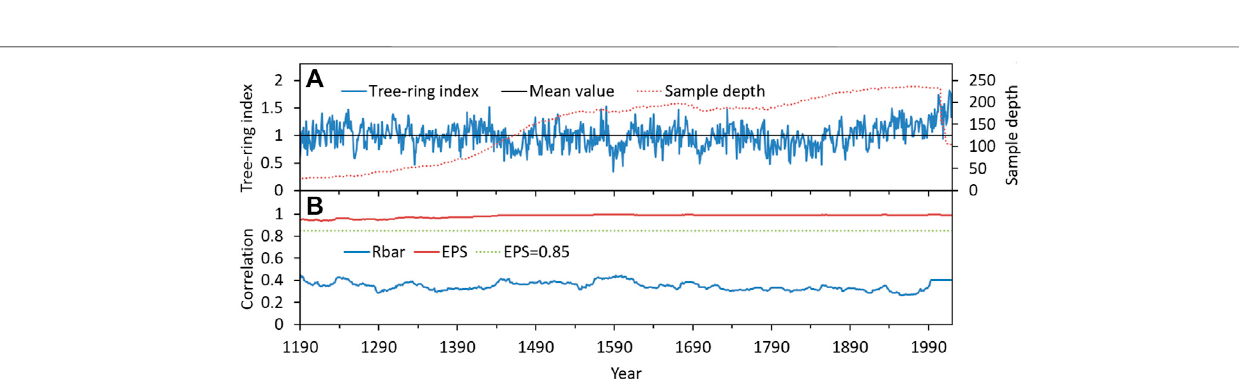
FIGURE 2 | Plots of (A) the composite chronology (bule line) and sample depth (red dotted line), and (B) running expressed population signal (EPS, blue line) and Rbar (mean correlation between ring-width series, red line) statistics.